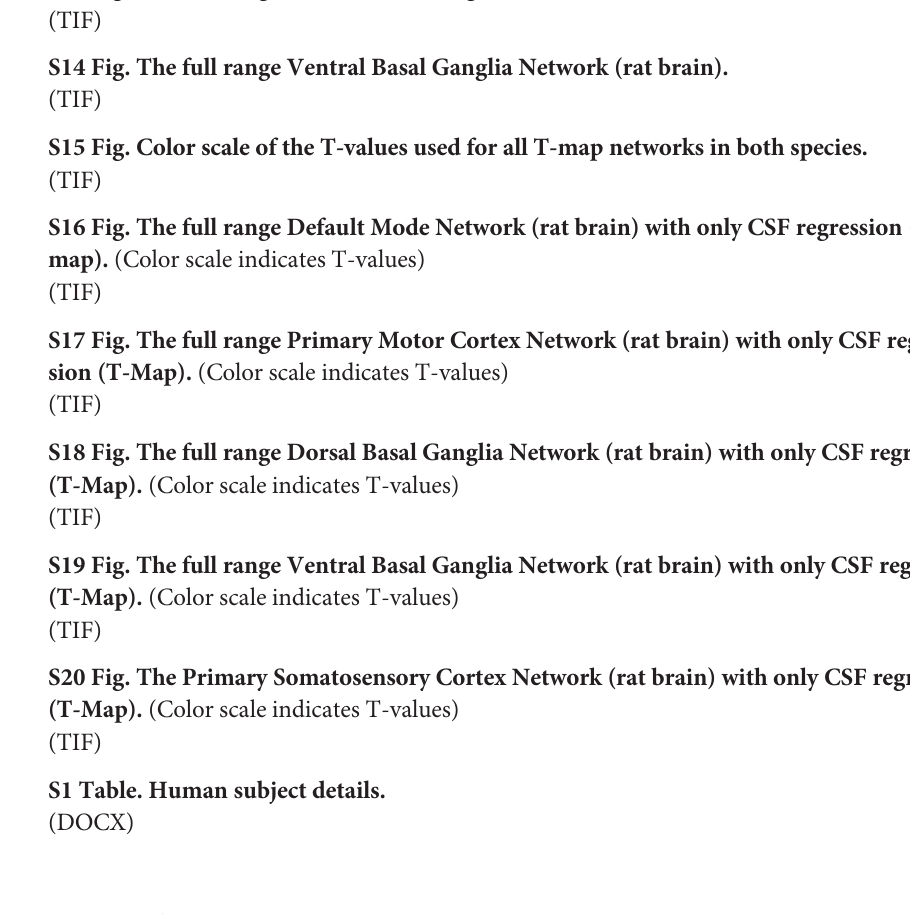
S7 Fig. The full range Primary Motor Cortex Network (rat brain). S8 Fig. The Primary Somatosensory Cortex Network (rat brain). (TIF) S9 Fig. The full range Primary Somatosensory Cortex Network (rat brain). (TIF) S10 Fig. The Primary Somatosensory Cortex Network (human brain). S11 Fig. The Primary Somatosensory Cortex Network (human brain). Displayed in the pri- mary motor cortex orthogonal view. S12 Fig. The Primary Motor Cortex Network (human brain). Displayed in the primary so- matosensory cortex orthogonal view. S13 Fig. The full range Dorsal Basal Ganglia Network (rat brain). S14 Fig. The full range Ventral Basal Ganglia Network (rat brain). S15 Fig. Color scale of the T-values used for all T-map networks in both species. S16 Fig. The full range Default Mode Network (rat brain) with only CSF regression (T- map). (Color scale indicates T-values) S17 Fig. The full range Primary Motor Cortex Network (rat brain) with only CSF regres- sion (T-Map). (Color scale indicates T-values) (TIF) S18 Fig. The full range Dorsal Basal Ganglia Network (rat brain) with only CSF regression (T-Map). (Color scale indicates T-values) (TIF) S19 Fig. The full range Ventral Basal Ganglia Network (rat brain) with only CSF regression (T-Map). (Color scale indicates T-values) (TIF) S20 Fig. The Primary Somatosensory Cortex Network (rat brain) with only CSF regression (T-Map). (Color scale indicates T-values) (TIF) S1 Table. Human subject